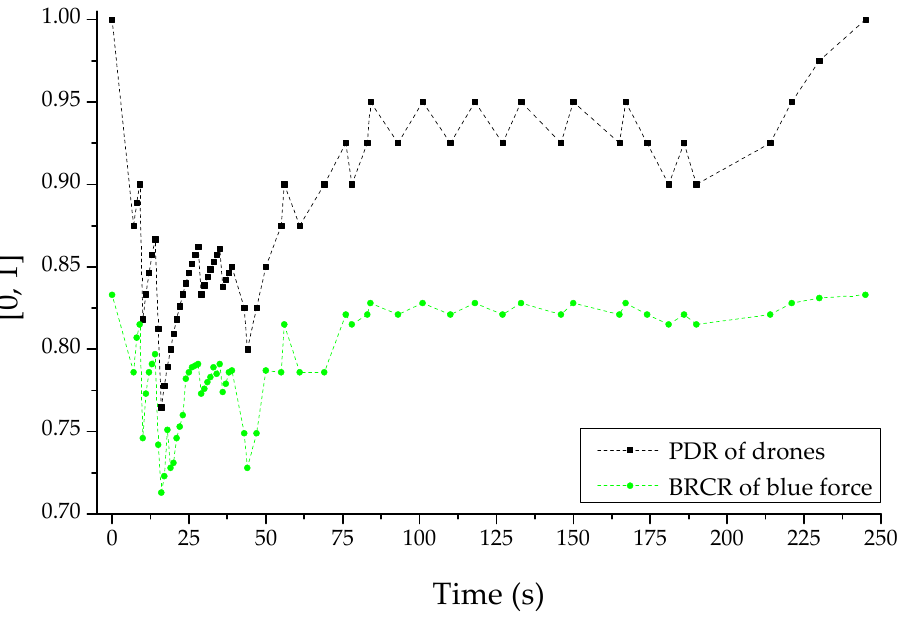
Figure 16. PDR (packet delivery ratio) and BRCR (blue remaining combat ratio)-based graph with channel hopping-based anti-jamming about attacker’s jammer.